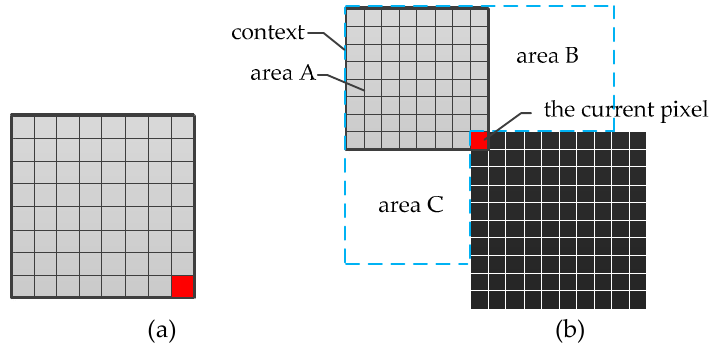
Figure 5. The red square is the current missing pixel, the gray squares are the available pixels, and the black squares are the unavailable pixels. ( a ) The template with square shape. ( b ) The context of the current missing pixel through matching the square template.